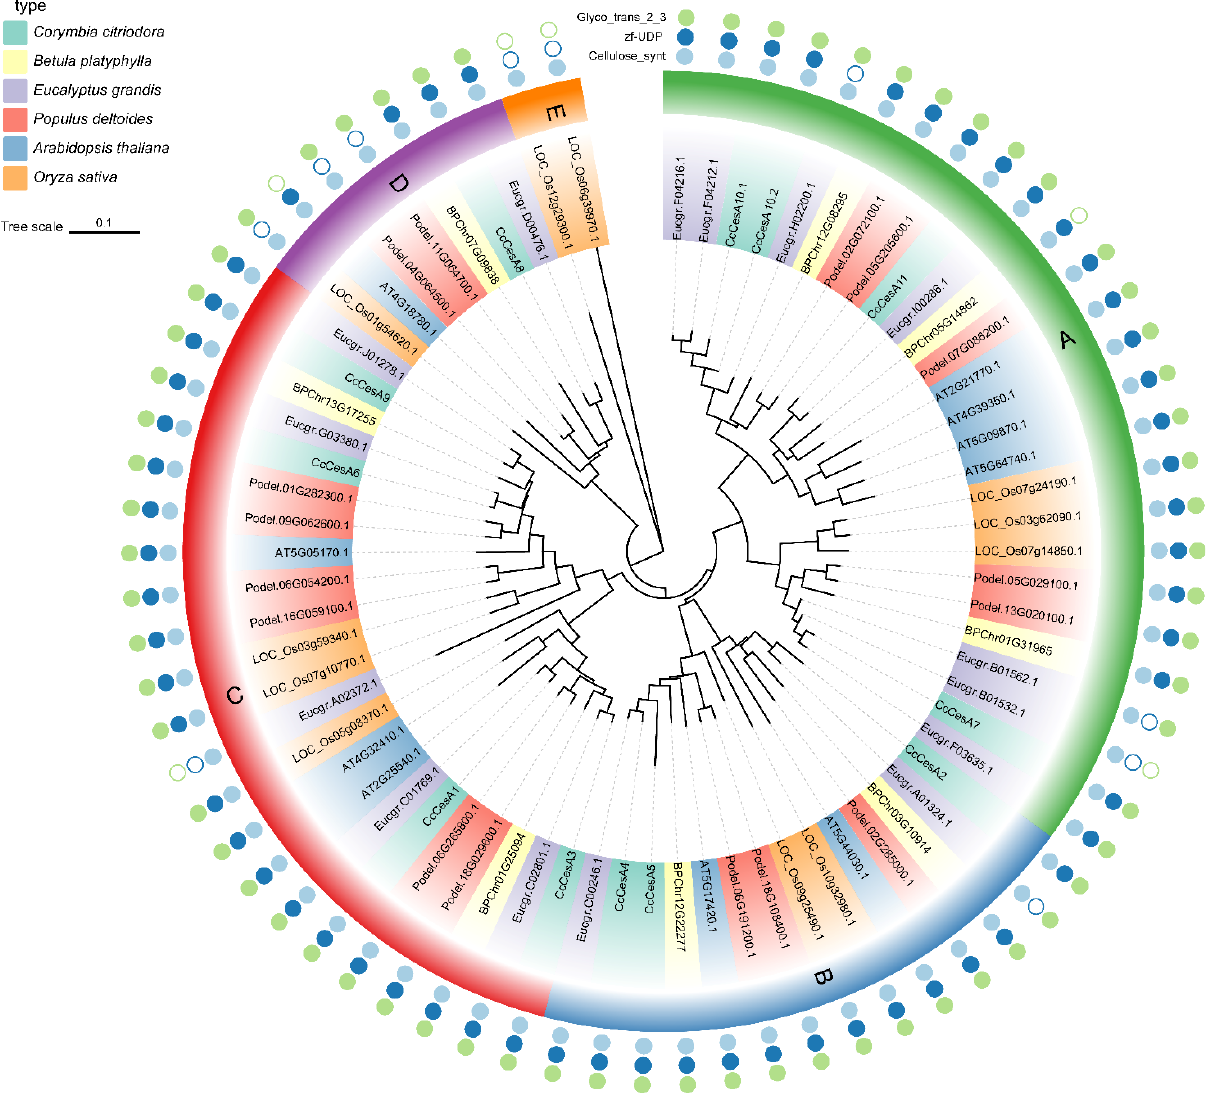
Figure 1. Phylogenetic tree of CesAs. Different species are shown in different colors. Groups A–E represent the classification of genes in the evolutionary tree. Solid and hollow circles correspond to the presence or absence of protein domains.